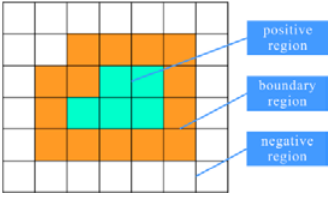
Figure 1. An illustration of the standard rough set with positive, boundary and negative regions.